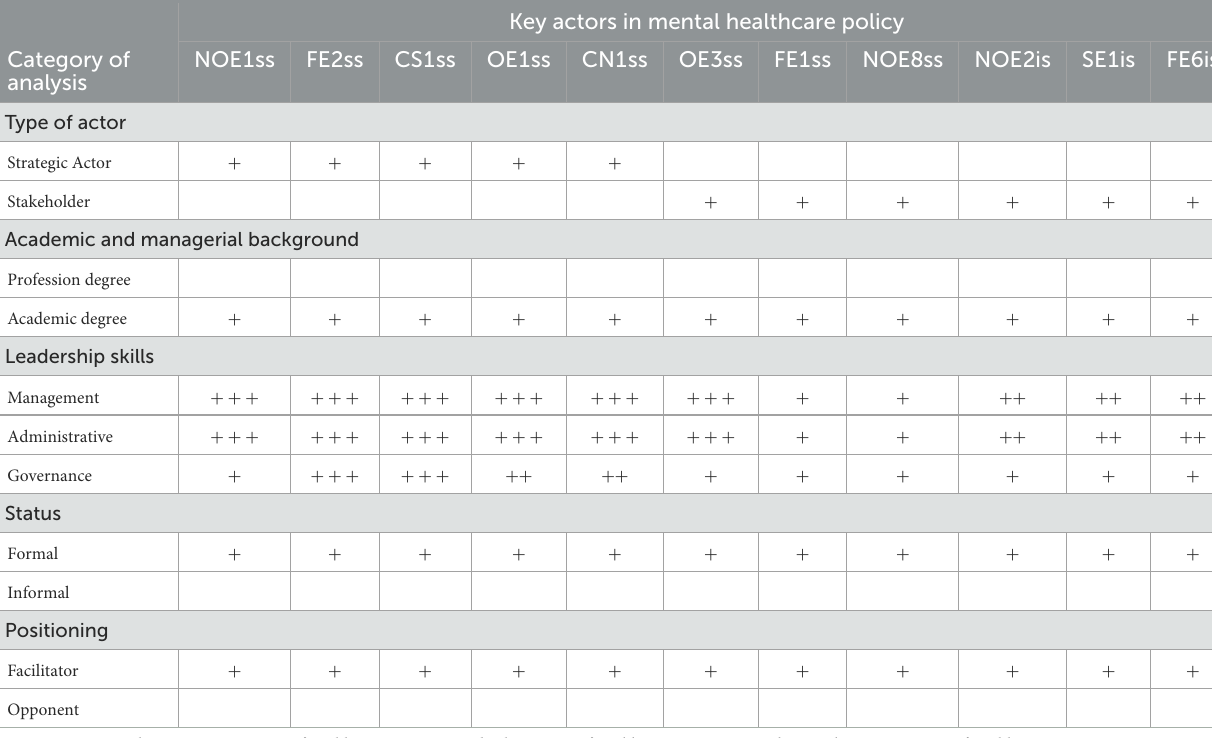
TABLE 2 Characterization of the key actors in the Mexican healthcare